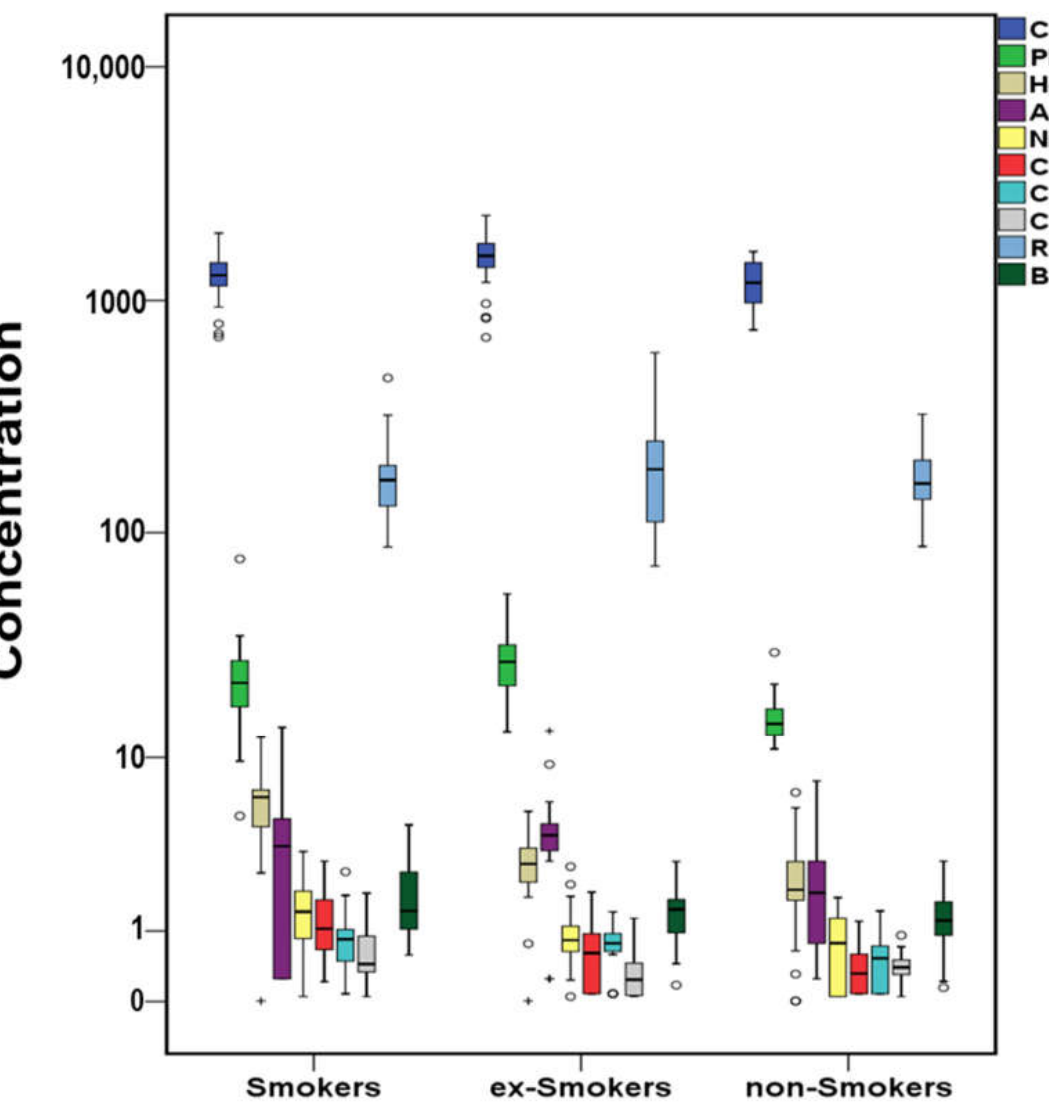
Figure 8. Variation of trace elements (μg L −1 ) in cases’ serum regarding the smoking habit ( + outliers, o values above 3rd quartile and * p -value <0.05) in logarithmic scale.